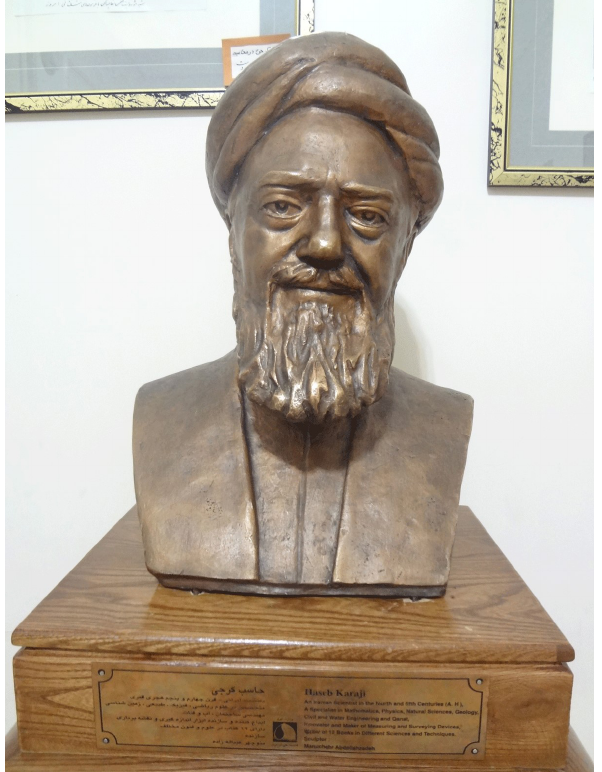
Figure 1. Abubakr Mohammad Karaji (953CE–1029CE) statue, created by Manouchehr Abollahzadeh, placed at the Water Museum of the Sa’dabad Museum Complex in Tehran, Iran (http://sadmu.ir/ post/6, last access: 31 July 2019).